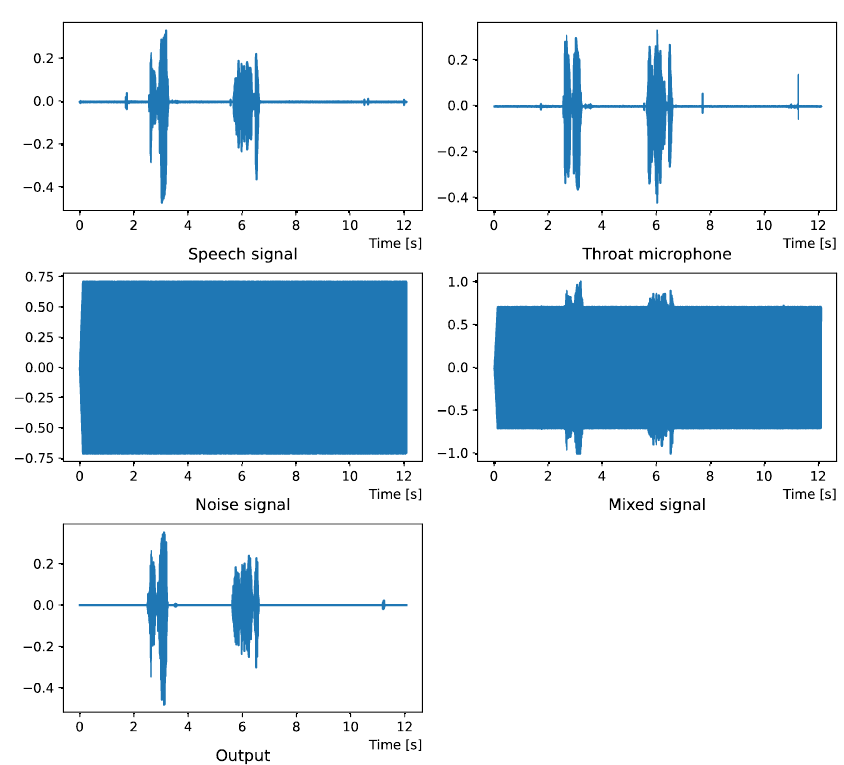
Figure 3. Spectrogram (Intersection noise).